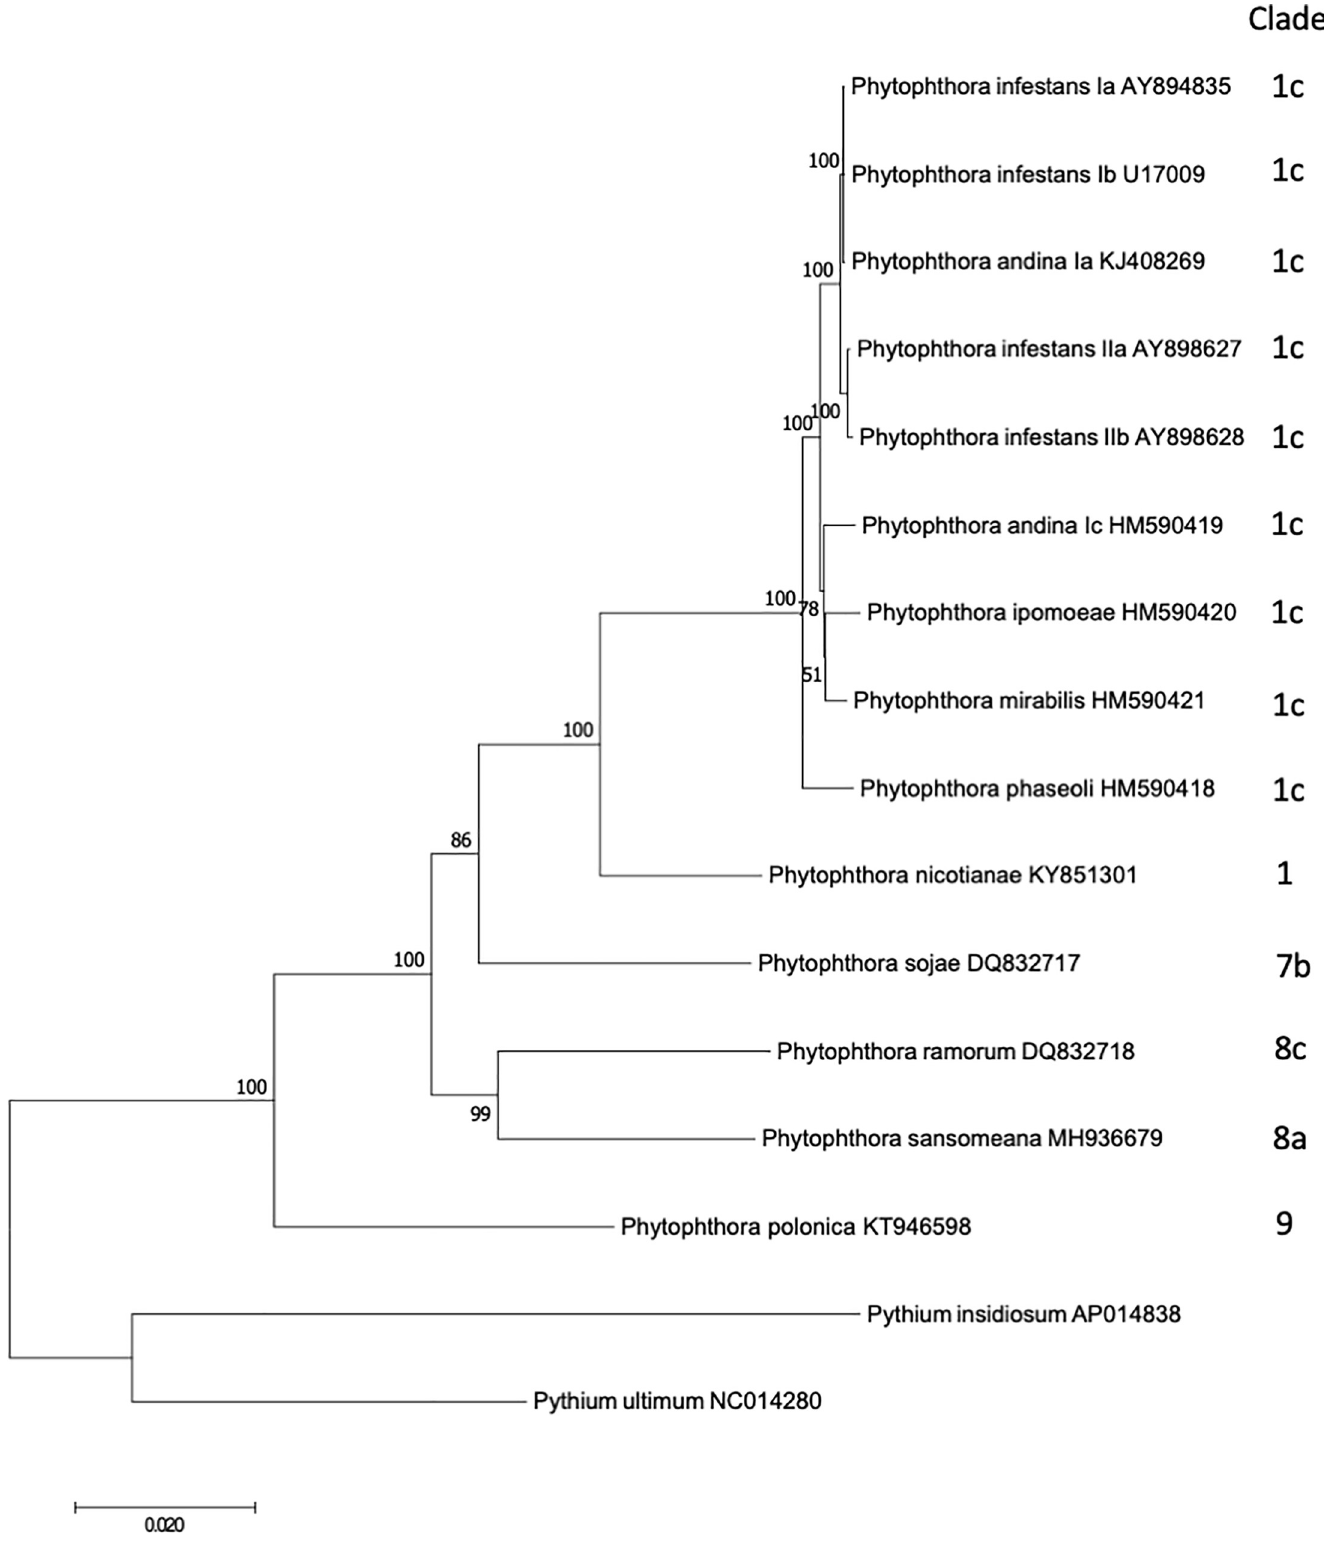
Fig 4. A maximum-likelihood tree based on the mitochondrial genomes. Branch support over 50% out of 1,000 bootstraps are shown. a Clade designation is based on [11, 12].